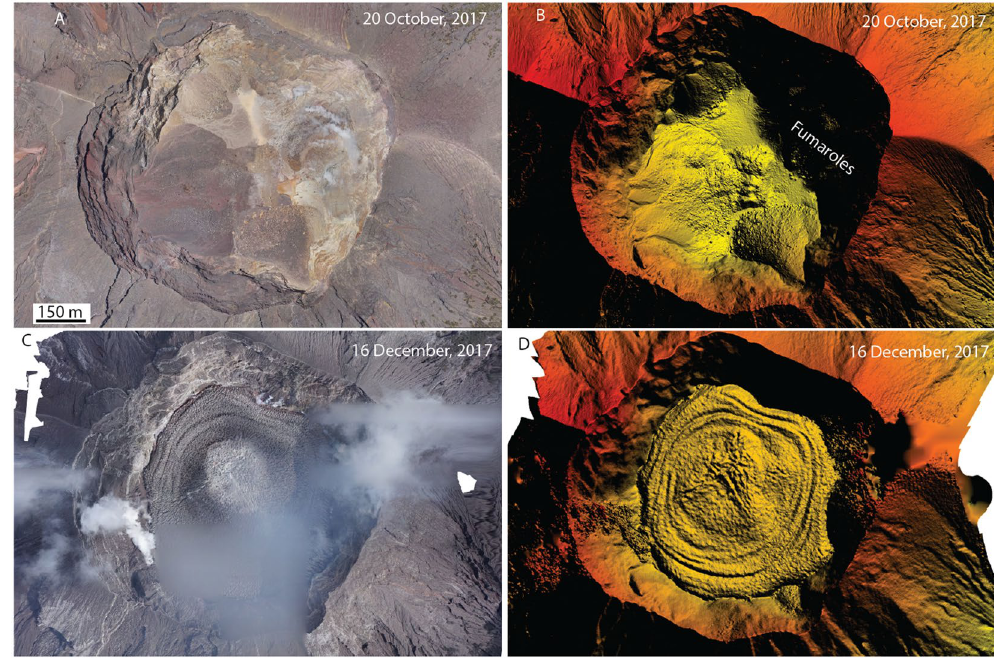
Figure 5. Images captured by drone flights over Mt. Agung crater on 20 October 2017 and 16 December 2017. ( A ) Rectified photo montage of pre-eruption conditions with steaming in the eastern wall. ( B ) Hillshade digital elevation model with false colors showing relative elevation (yellow to red). ( C ) Post-eruption photo montage that shows the lava flow. ( D ) Hillshade digital elevation model as in ( B ), where the lava flow contains concentric pressure ridges created during outward flow from the central vent. Cracks are visible propagating from the center vent